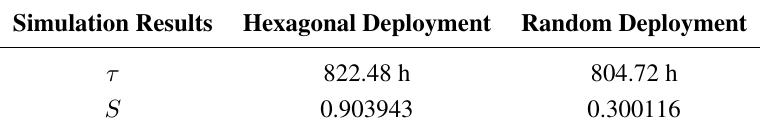
Table 5. Optimization results of uniform deployment.